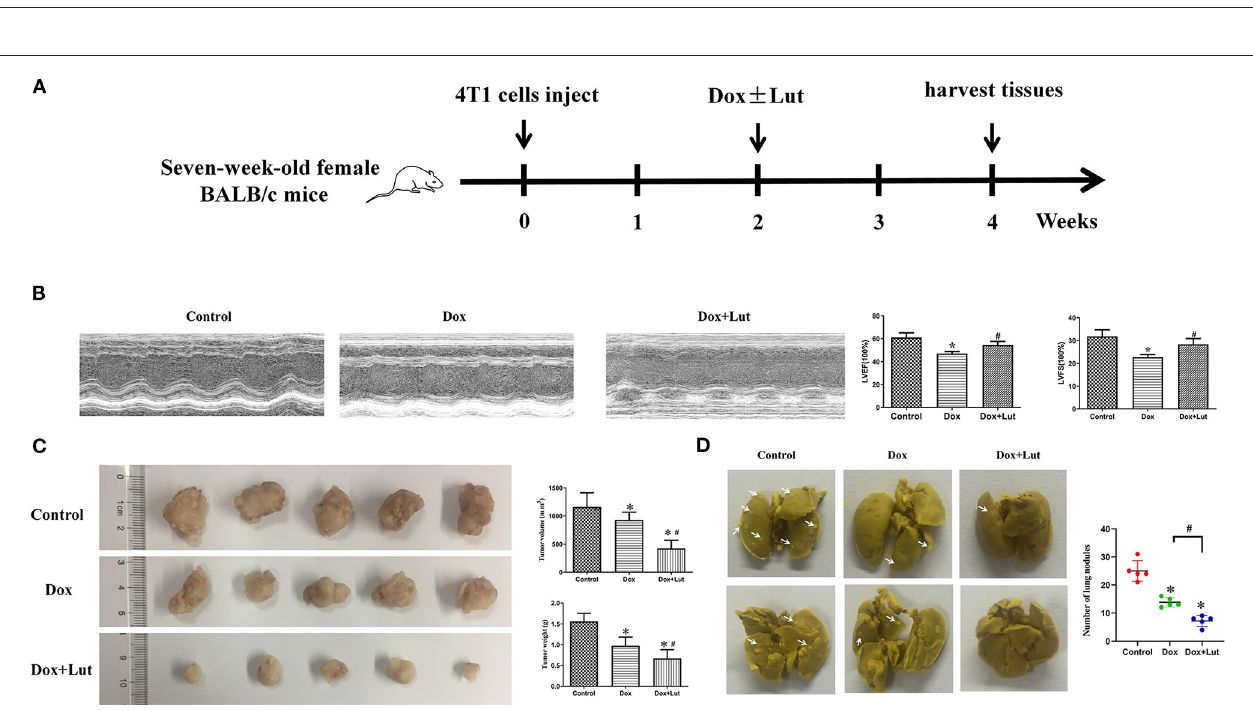
FIGURE 10 | Lut prevents the cardiotoxicity and promotes the antitumor effect induced by Dox in vivo . (A) Diagram showing the scheme for tumor implantation and Lut treatment. (B) Echocardiographic assay was used to determine the attenuated left ventricular dysfunction of Lut on Dox-induced cardiac dysfunction in mice. (C) Image of tumors from different groups. The weight and size of the tumor was measured. (D) Typical lung nodules in mice from different groups. * P < 0.05 compared with control group. # P < 0.05 compared with Dox group.